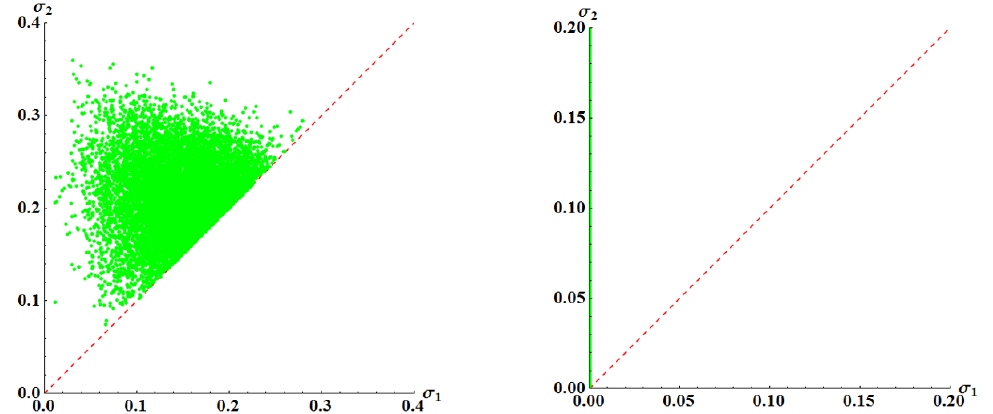
Figure 4 . Left : the scatter plot of (cid:27) 1 and (cid:27) 2 in the case A. The value of z is set to be 1. Right : the scatter plot of (cid:27) 1 and (cid:27) 2 in the case B. We have set b = c = 1. In both (cid:12)gures, the gauge couplings in the embedding tensor are assigned to take the values in f(cid:0) 0 : 1 ; 0 : 1 g and there are 10 4 sample